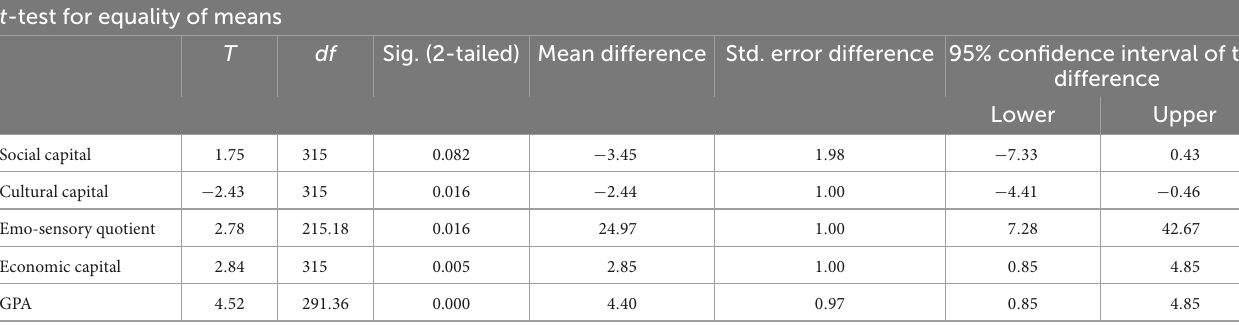
TABLE 4 Results of the independent samples t -test on the Iranian and Afghan data. t -test for equality of means T df Sig. (2-tailed) Mean difference Std. error difference 95% confidence interval of the